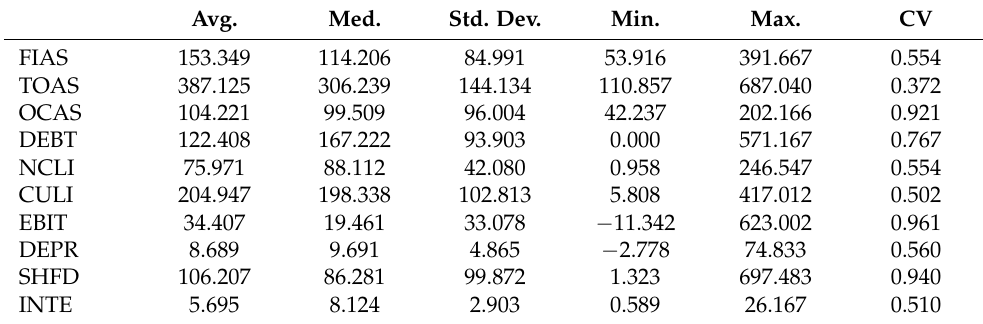
Table 1. Descriptive statistics covering distinct financial indicators (in thousand euros).